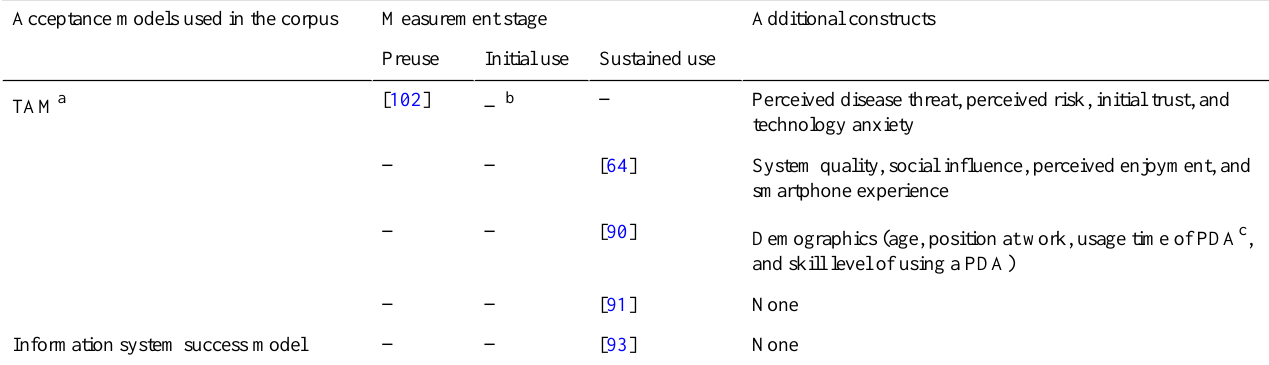
Table 5. Use of existing technology acceptance